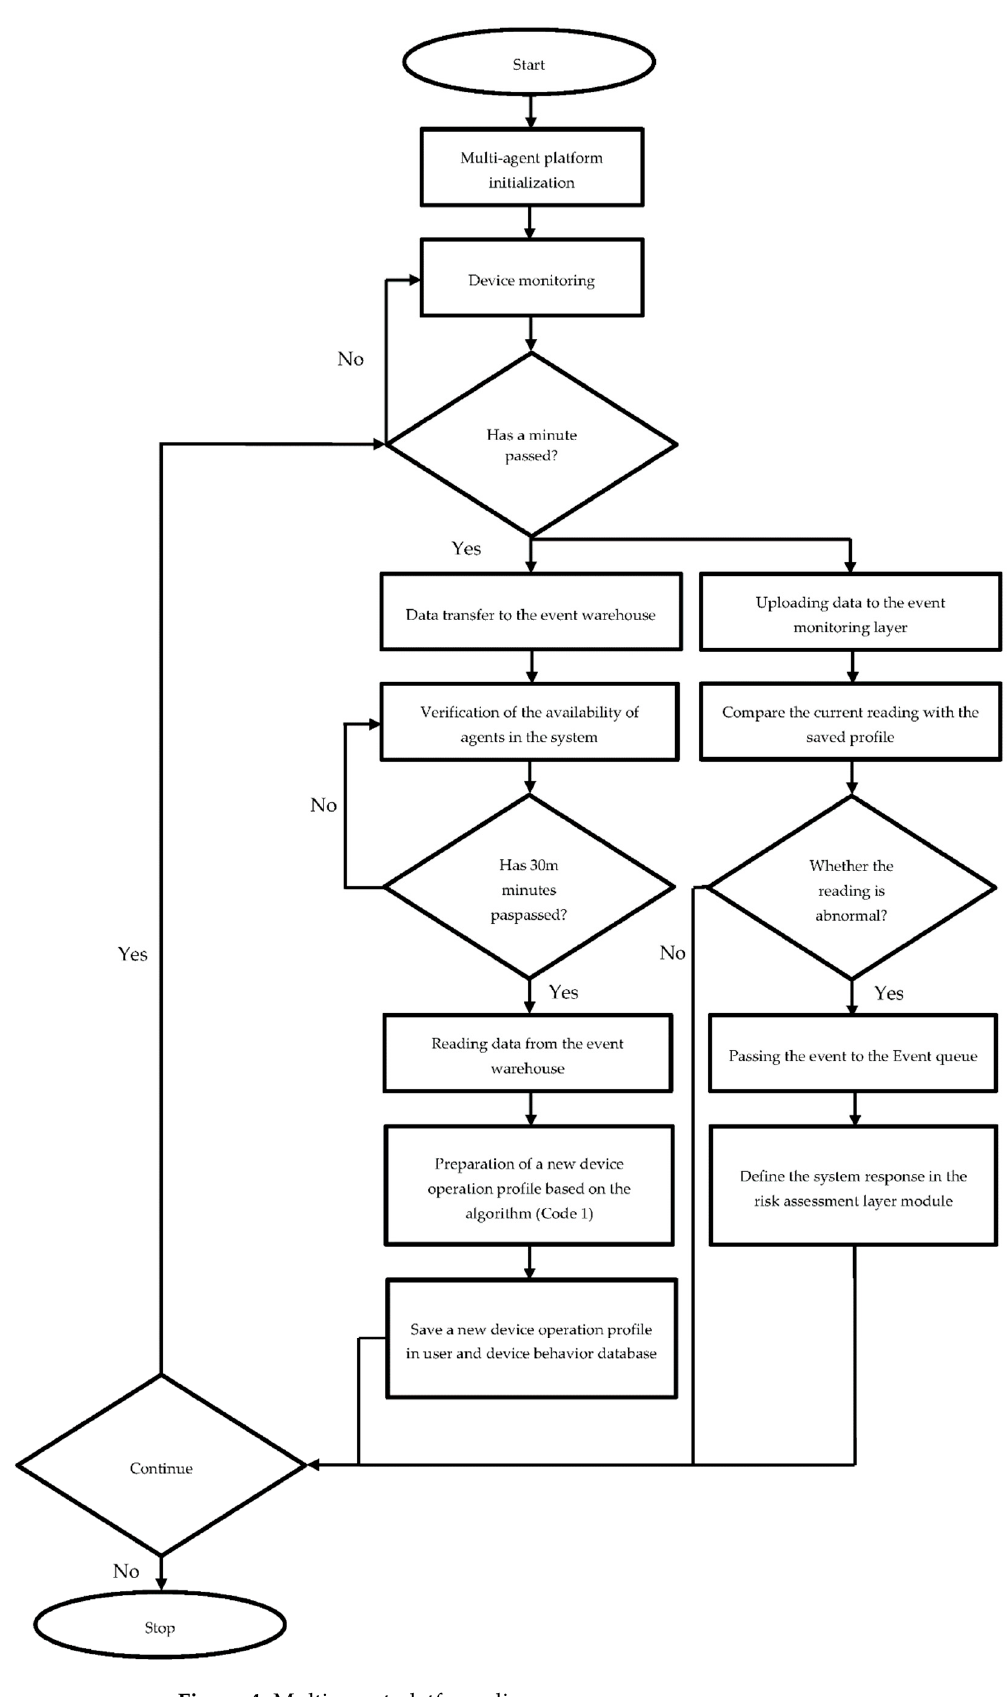
Figure 4. Multi-agent platform diagram.